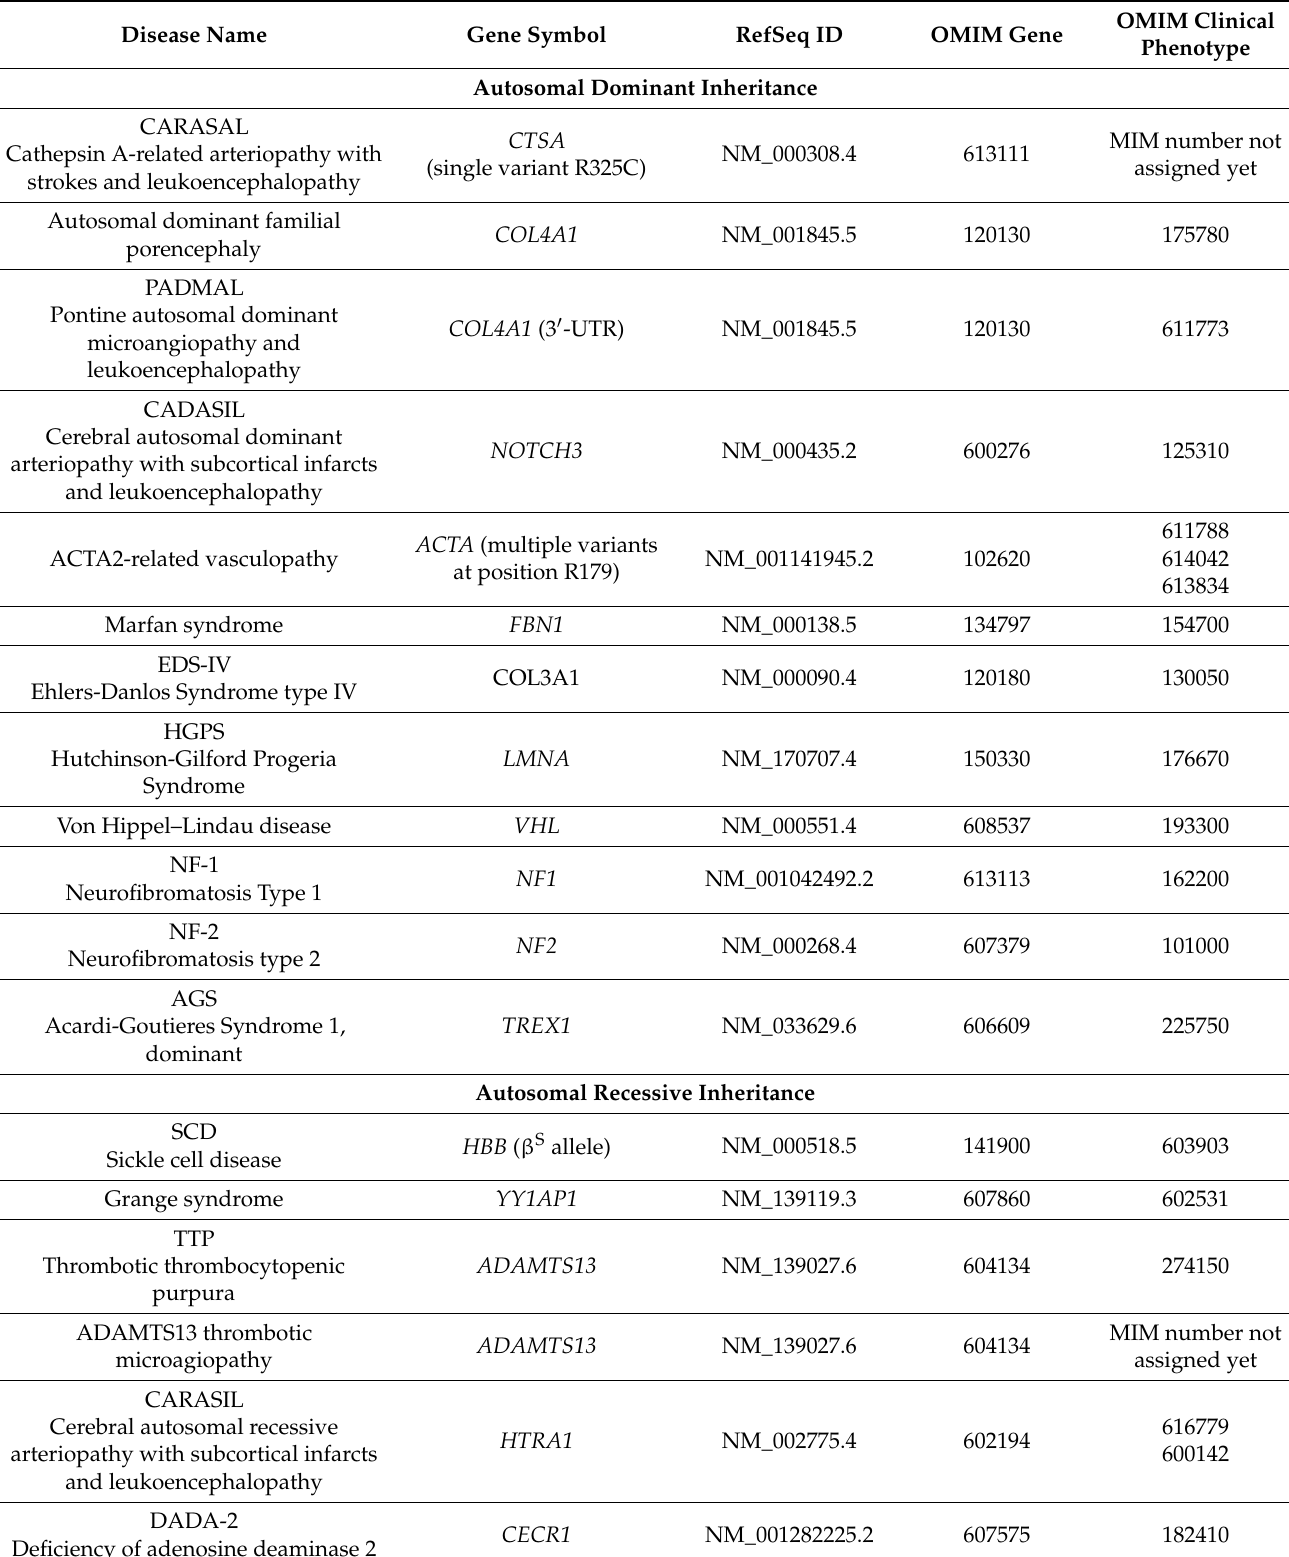
Table 1. The most significant monogenic conditions associated with pediatric stroke, organized by mode of